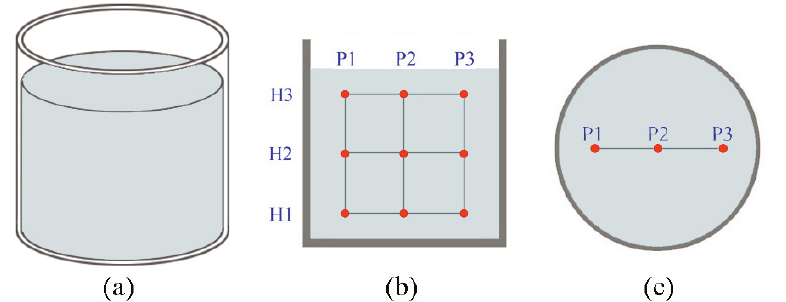
Figure 1. ( a ) Animal fat in the cylindrical sample holder, and thermocouples positioning within the sample in ( b ) a vertical section at x = r , and ( c ) a horizontal section at z =